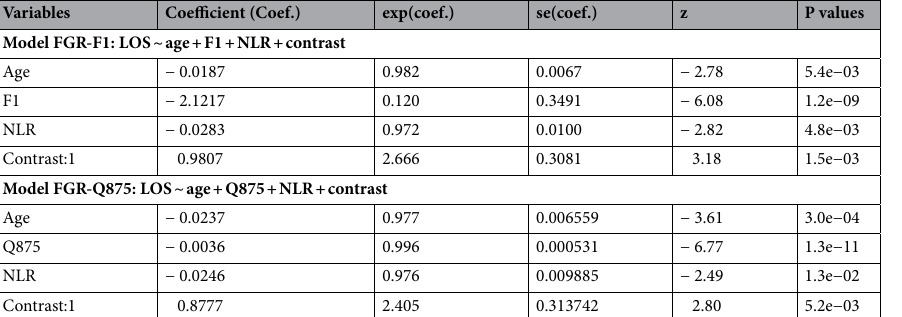
Table 3. Multivariate fine-gray regression (FGR) proportional hazards models FGR-F1 and FGR-Q875 for the subdistribution of a competing risk with primary outcome: hospital length-of-stay (LOS) and the competing risk (death). All variables in both models have significant effect on the cumulative incidence of the primary outcome (LOS) while controlling for the competing risk (death). Negative coefficients indicate that an increasing value of the variables (age, NLR, F1, Q875) is associated with a decreasing incidence of the hospital discharge (that is, an increasing LOS). Conversely, a positive coefficient (for the Contrast CT factor) indicates an increased incidence of hospital discharge (and reduced LOS). exp(Coef.) exponentiated coefficient, se(coef.) standard error of the variable coefficient. N =